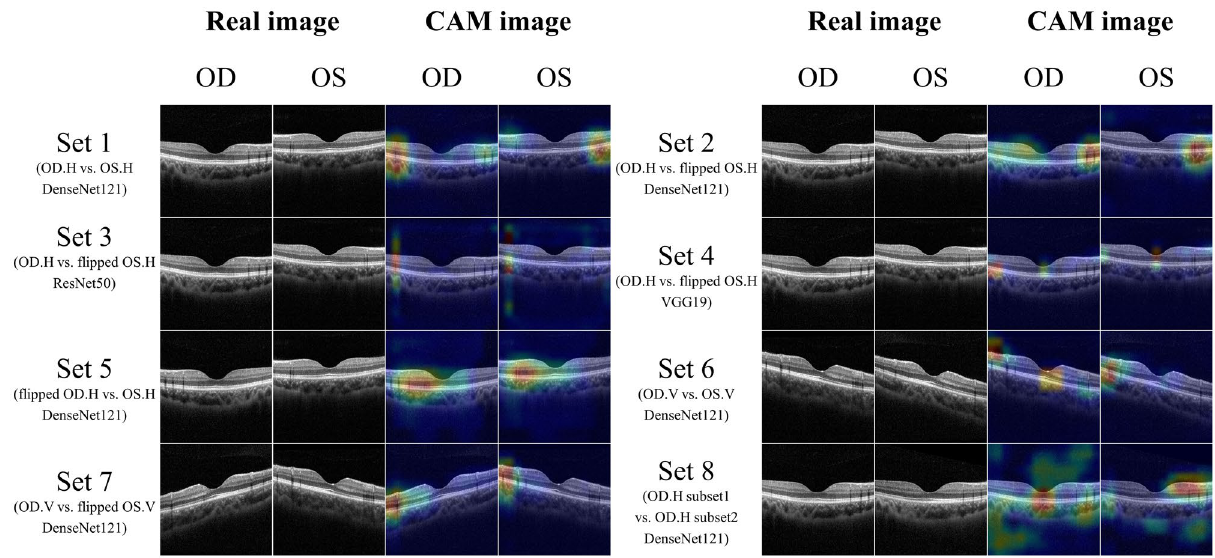
Figure 5. Image sets and their corresponding class activation mapping (CAM) results. Set 1 consisted of horizontal images of right and left eyes. Papillomacular retinal nerve fiber layers with high reflectivity were shown on the nasal side of the image. CAM highlights both ends of parafoveal regions of images. Sets 2–4 consisted of right horizontal images and flipped left horizontal images. Papillomacular retinal nerve fiber layers with high reflectivity were shown in the right-side of OCT images. CAM patterns in Sets 2–4 differed: DenseNet121 highlighted the parafovea, whereas ResNet50 highlighted only the parafovea and VGG19 both the parafovea and macula. Set 5 consisted of flipped right and left horizontal images; CAM highlighted the parafovea, similar to Set 2. Set 6 consisted of vertical OCT images of right and left eyes. From Set 6, heatmaps highlighting the parafovea and macular region were produced. Set 7 comprised non-flipped right vertical images and flipped left vertical OCT images; the ends of the parafoveal regions were highlighted. Set 8 consisted only of right horizontal images. Unlike Sets 1–7, Set 8 images showed an irregular pattern, emphasizing the vitreous region and outside of the sclera. OD oculus dexter, OS oculus sinister, H horizontal, V